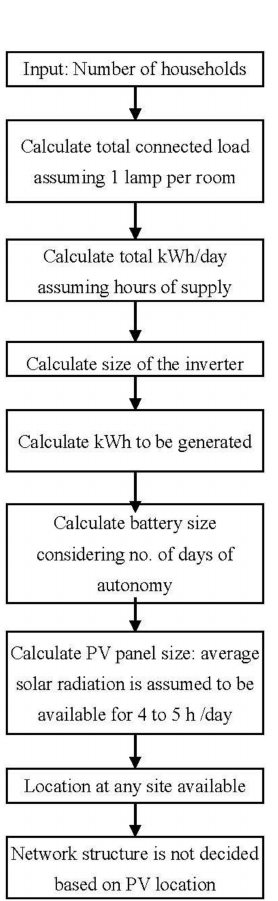
Figure 1. Typical procedure followed by planners for design of photovoltaics (PV) based rural